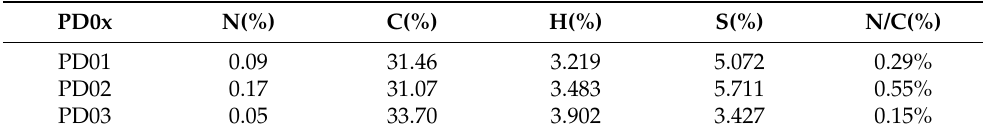
Table 2. Elemental analysis results of dispersant PD0x.